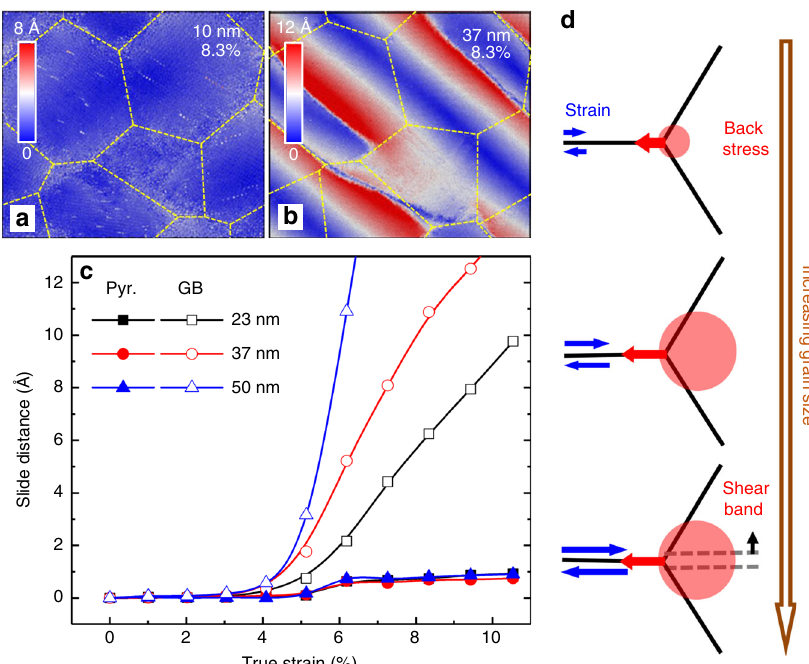
Fig. 4 Grain size dependence of strain accommodation. a , b Displacements of atoms relative to their positions in the unstrained samples under the strain of 8.3% for grain sizes of 10 nm ( a ) and 37 nm ( b ), respectively. c Displacements as functions of applied strain for a pyramidal 2 c + a slip (shown in Fig. 2) and the GB sliding (shown in Fig. 3) for samples with different grain sizes. The same location of slip/sliding was chosen in each sample. Examples from other locations show the same qualitative trend (Supplementary Fig. 14). d A schematic illustration of how GB sliding distance results in back stress for samples with different grain